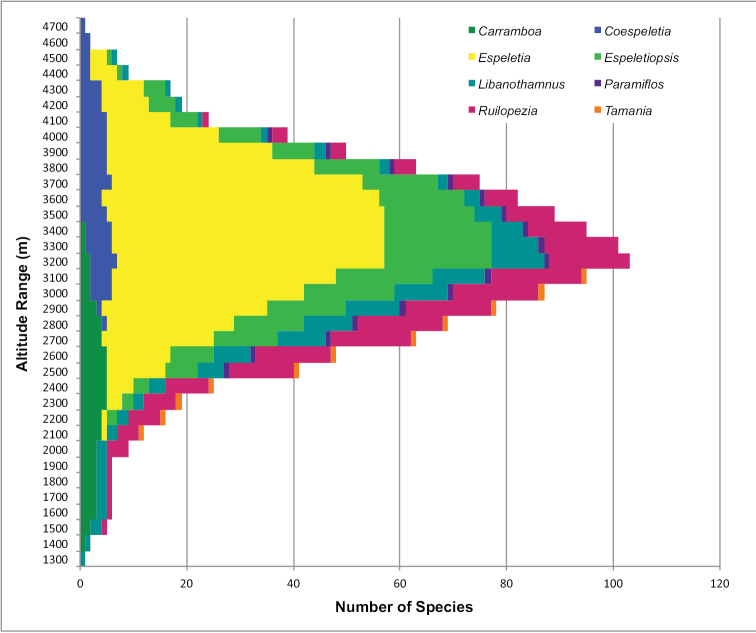
Richness of species throughout the elevation gradient. Each color represents species of each of the genera. Libanothamnus neriifolius has been reported as low as 1300 m, while Coespeletia timotensis has been found at 4780 m. Most of the species (104) grow in elevations between 3200 and 3400 m.